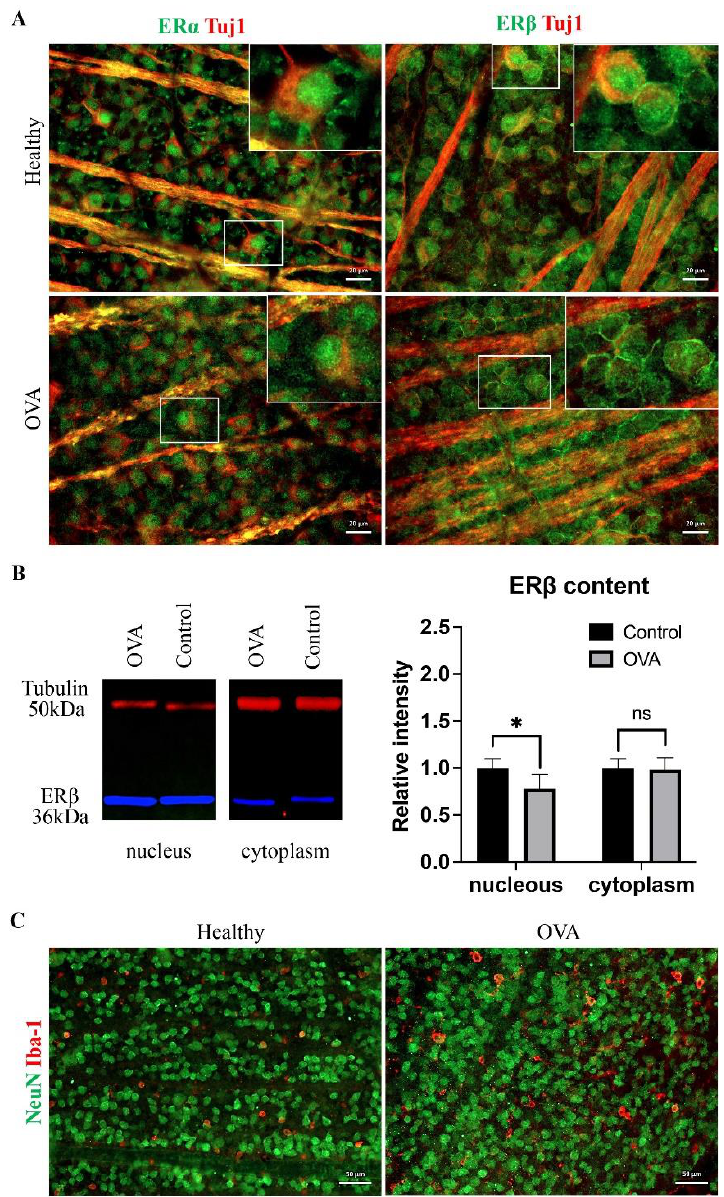
Figure 2. Immunofluorescence staining of whole mounted retinas. ( A ) The difference between the cellular localization of ERα and ERβ (green) colocalized with Tuj1 (red) in the healthy and OVA groups. Scale bar: 20 μm. ( B ) WB analysis of ERβ nuclear and cytoplasmic fraction in OVA and control (healthy) group, ns: not significant, *: p < 0.03, Welch’s t test. ( C ) Microglial cell infiltration positive for Iba-1 (red) double- stained with NeuN (green). Scale bar: 50 μm.